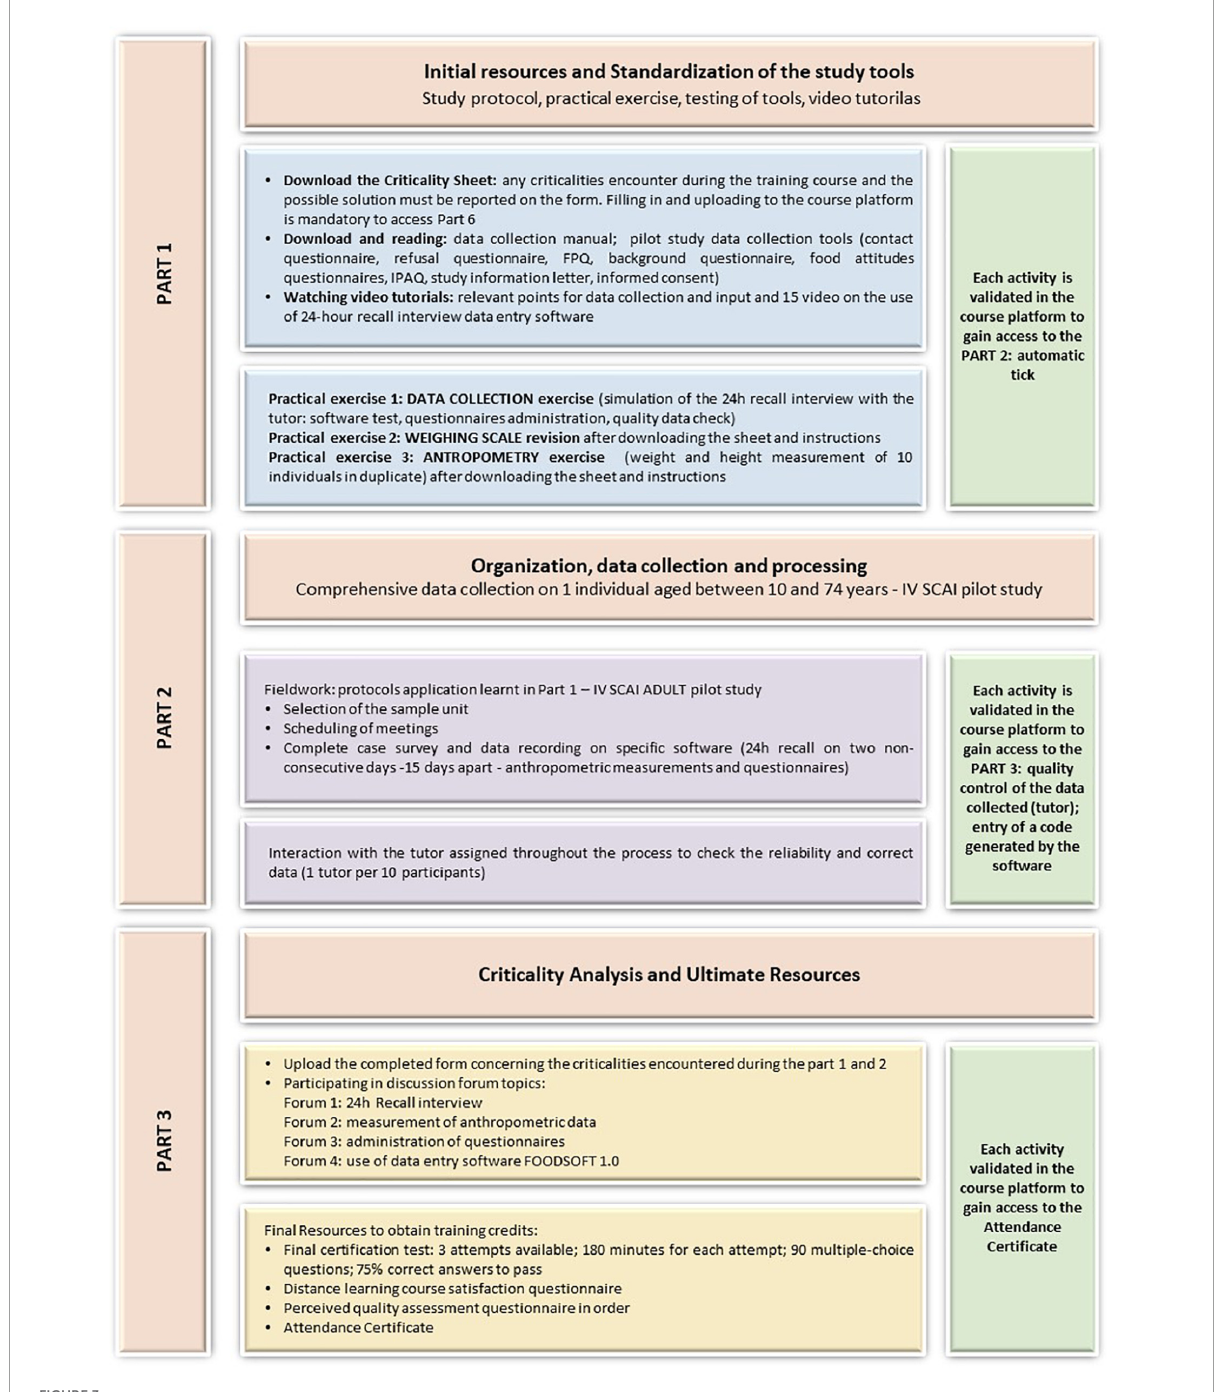
FIGURE3 IV SCAI ADULT course path—Main steps of the highly interactive distance learning path—DLC2.